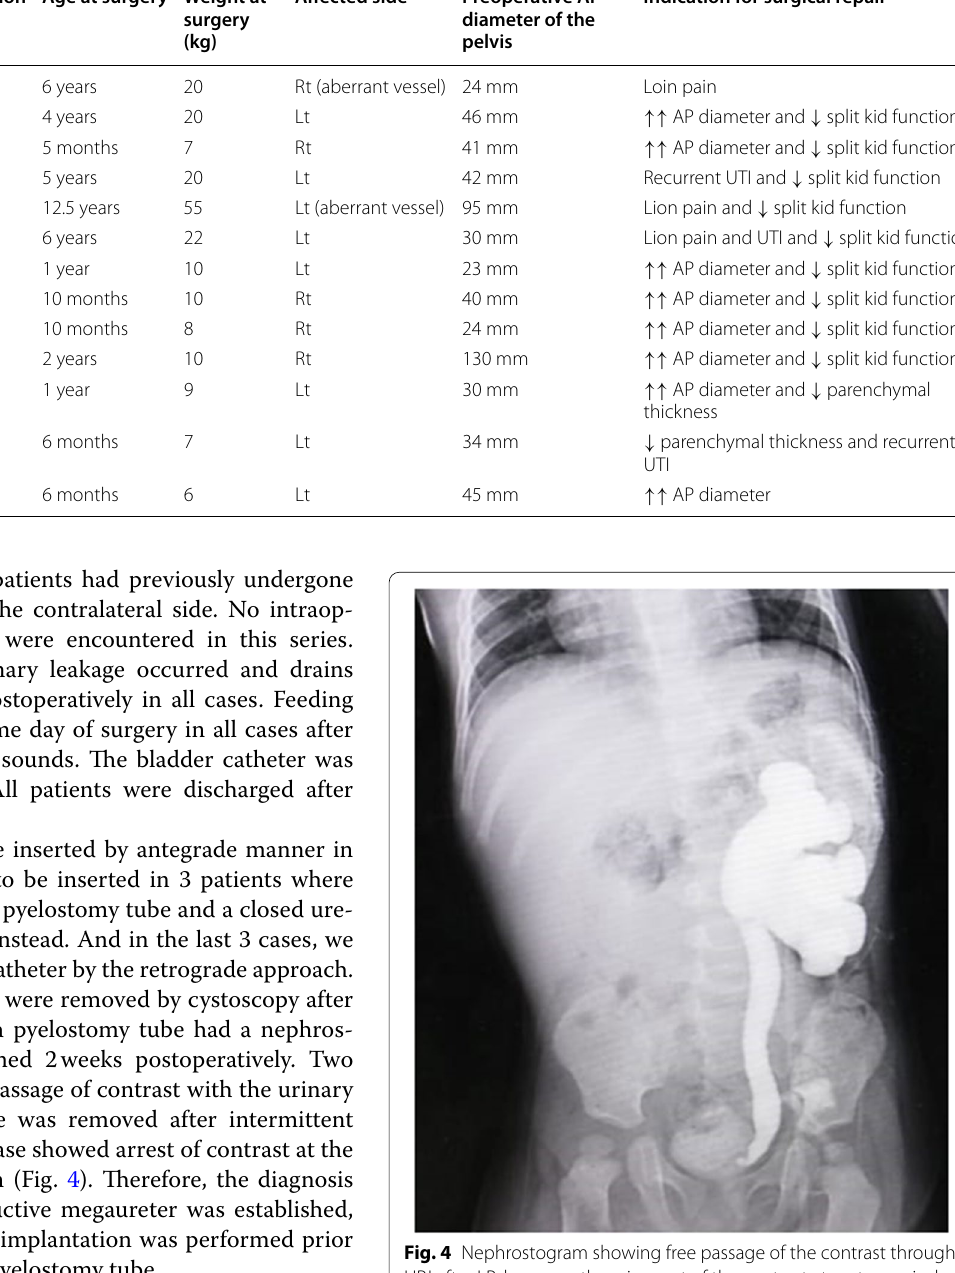
Table 1 Preoperative patients characteristics Case no. Age at presentation Age at surgery Weight at